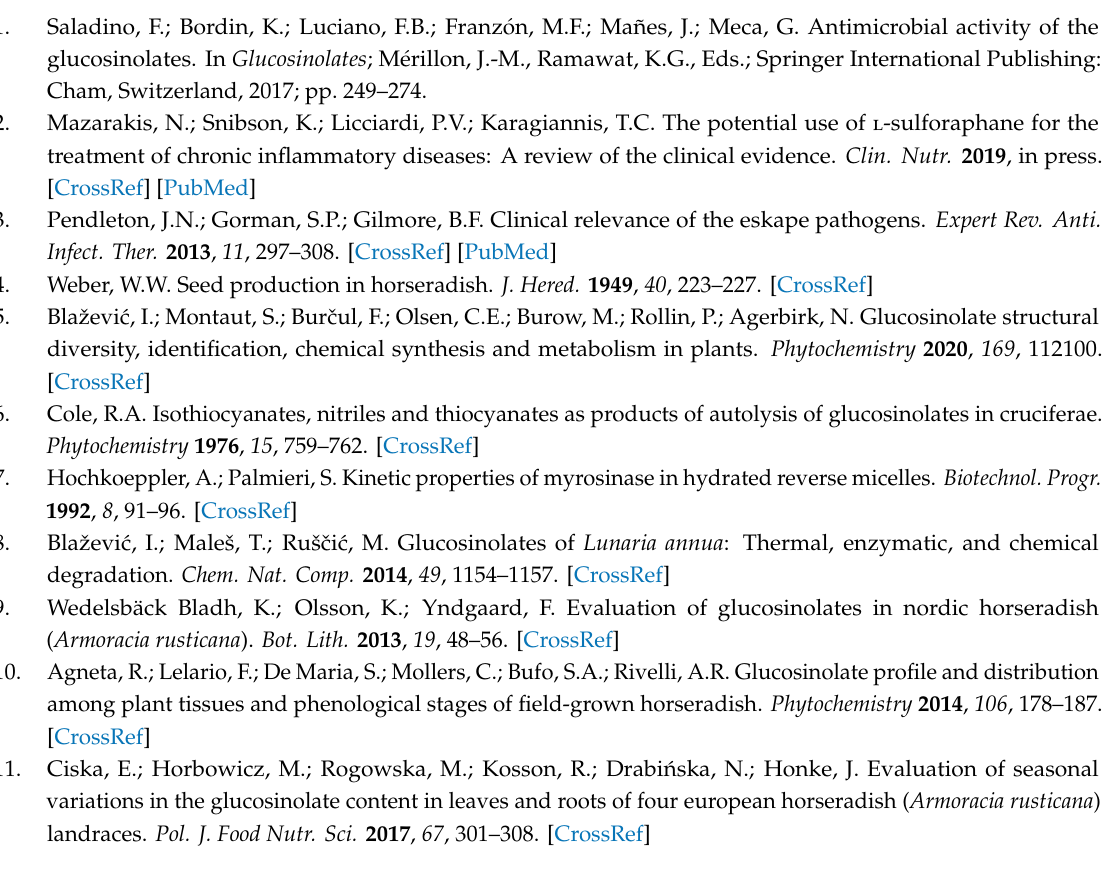
Figure S1: Chromatogram of desulfoglucosinolates obtained from the roots and the leaves of horseradish: d1 —desulfosinigrin; d2 —desulfogluconapin; d3 —desulfoglucobrassicanapin; d4 —desulfoglucocochlearin; —desulfogluconasturtiin; d6 —desulfoglucobrassicin, Figure S2: UV-Vis and MS 2 spectra at 15V ionization of 3 main desulfoglucosinolates detected: d1 , d5 , and d6 , Table S1: Calculated IC 50 values ( µ g / mL) for volatiles obtained by HD, MAD and MHG from the roots and the leaves of horseradish and its main compounds 2-phenylethyl ITC, 3-phenylpropanenitrile, allyl ITC, and their mixture in the proportion similar to the one obtained by root MAD, 7:2:1, respectively ( Ψ 7:2:1 ) against human lung cancer cell A549 and bladder cancer cell T24 lines after 72